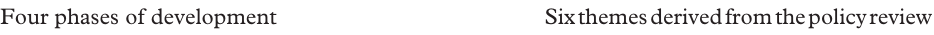
Table 1. The relationship between technological developments and policy focus Four phases of development Six themes derived from the policy review Centralised, time-share resources and expert